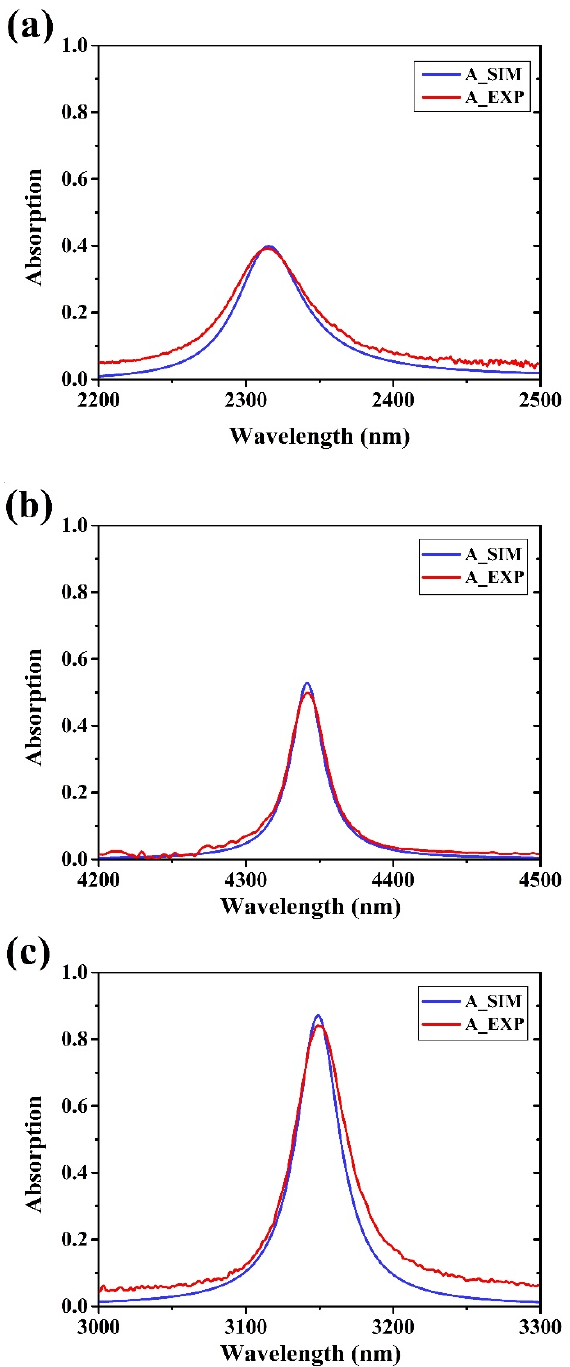
Figure 8. Comparison between simulated and experimental absorption curves of single layer graphene inside the Fabry–Perot filters: ( a ) symmetric FP1, ( b ) asymmetric FP2, and ( c ) asymmetric reflective FP3.